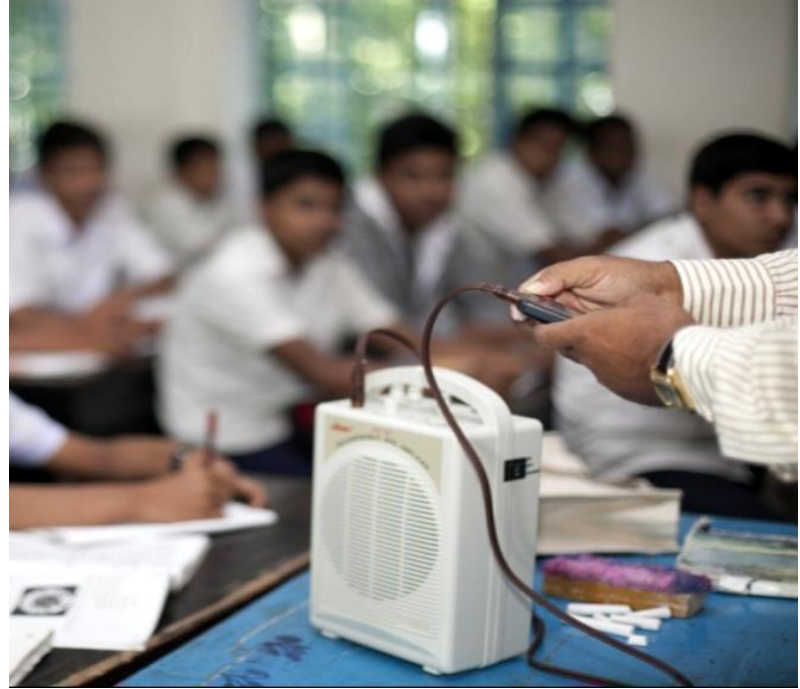
Figure 7 EIA’s mobile-phone-based technology kit known as ‘the trainer in your pocket’ EIA’s ‘trainer in your